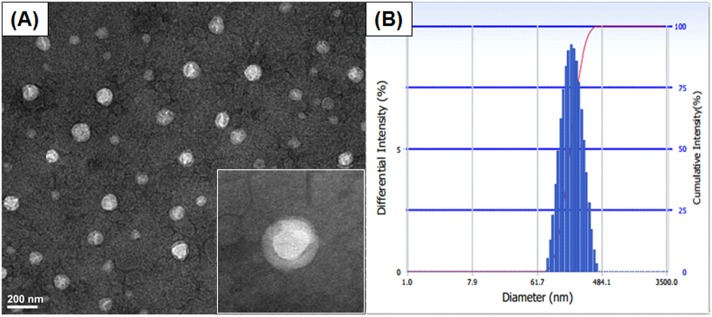
Characterization of CSO-g-CM-β-CD@AD-PTX micellar system.TEM images (A) and size distribution of CSO-g-CM-β-CD@AD-PTX micelles (B).